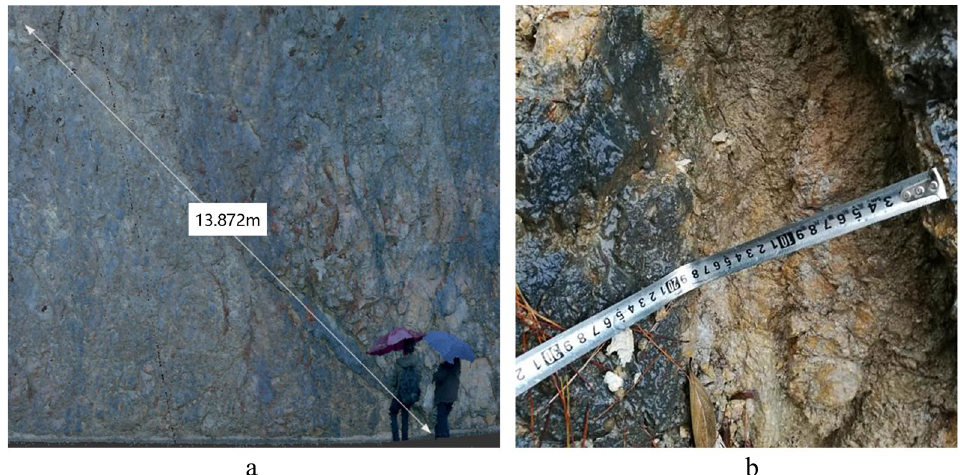
Figure 1. Grade III structural plane J 1 at 40 m from the inlet. ( a ) Overall appearance of muddy weak interlayer. ( b ) The average width of muddy weak interlayer.